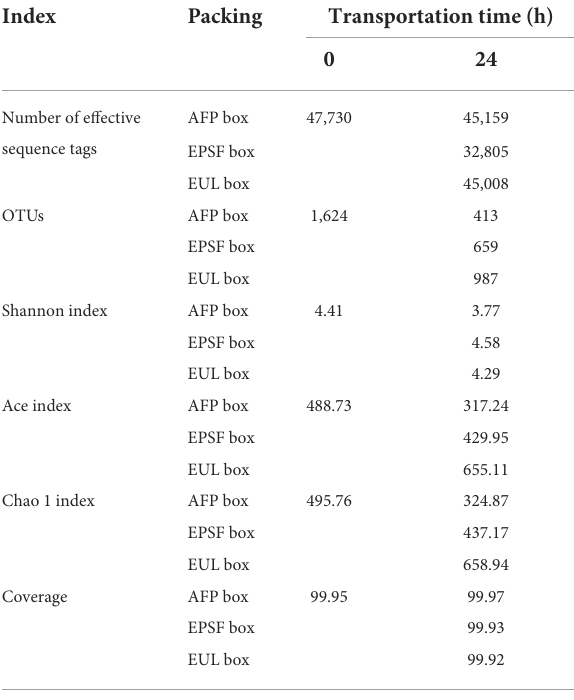
TABLE 2 Effects of different packing materials on the diversity of microbial in bigeye